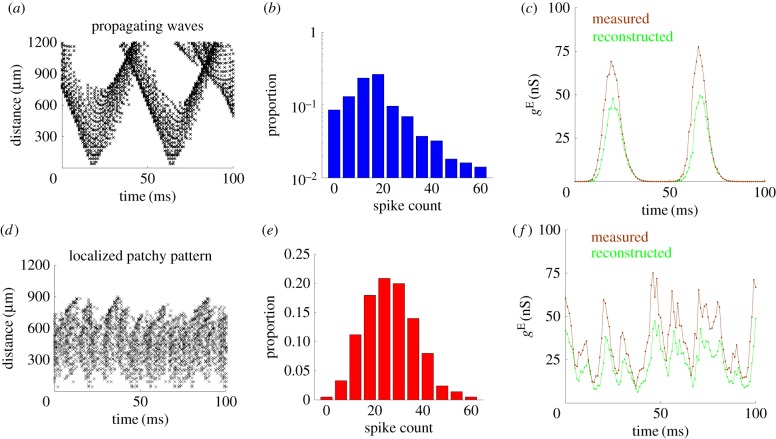
Population response patterns underlie the shift from the synchronous to the asynchronous state. (a) Average distance from spiking neurons, with each point depicted by a ‘ × ’, in propagating wave fronts to a test neuron during the spontaneous activity. The average distance rapidly decreases as a wave approaches and rapidly increases as a wave recedes. (b) Histogram of the number of spikes received by a test neuron, calculated using a Δt = 1 ms sliding window, for one trial during the spontaneous activity. Note the logarithmic scaling of the y-axis, emphasizing that the distribution is heavy-tailed. (c) The time series of excitatory conductance gE received by the test neuron during the spontaneous activity (brown line) closely matches the time series based on the spiking data (green line) in figure 4a. (d) Average distance from spiking neurons in a localized patchy pattern, each depicted by a ‘ × ’, to a test neuron in the RoI with a strong stimulus. Because the spikes occur at seemingly irregular configurations within the pattern, there is a constant fluctuation in the distances at which they occur. (e) Histogram of the number of spikes received by a test neuron, calculated using a Δt = 1 ms sliding window, for one trial during the activity evoked by a strong stimulus. The histogram appears to be approximately Gaussian. (f) The time series of excitatory conductance gE received by the test neuron during the activity evoked by a strong stimulus (brown line) closely matches the time series based on the spiking data (green line) in figure 4d.